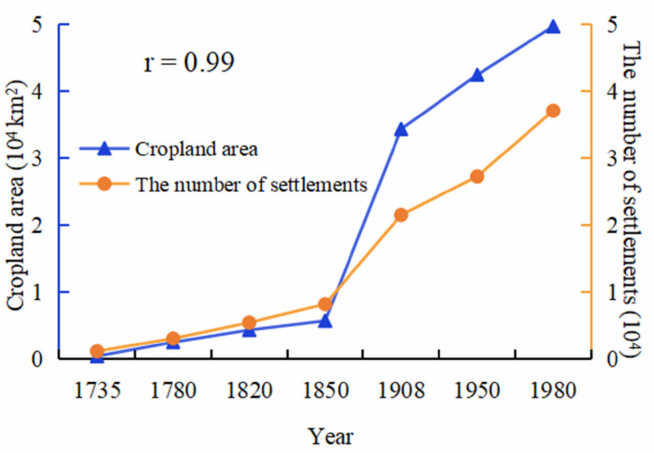
Figure 6. Changes in the cropland area and the number of settlements over the last 300 years in Jilin Province